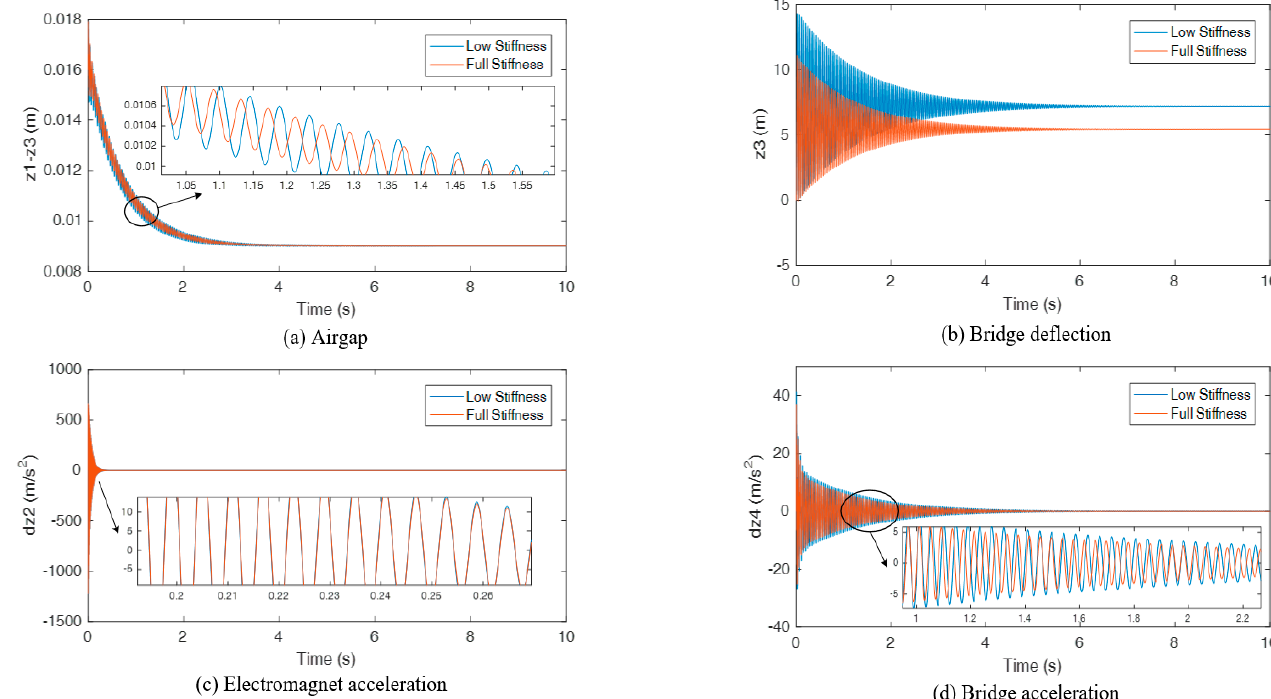
Figure 4. Dynamic response of the system with different stiffness.